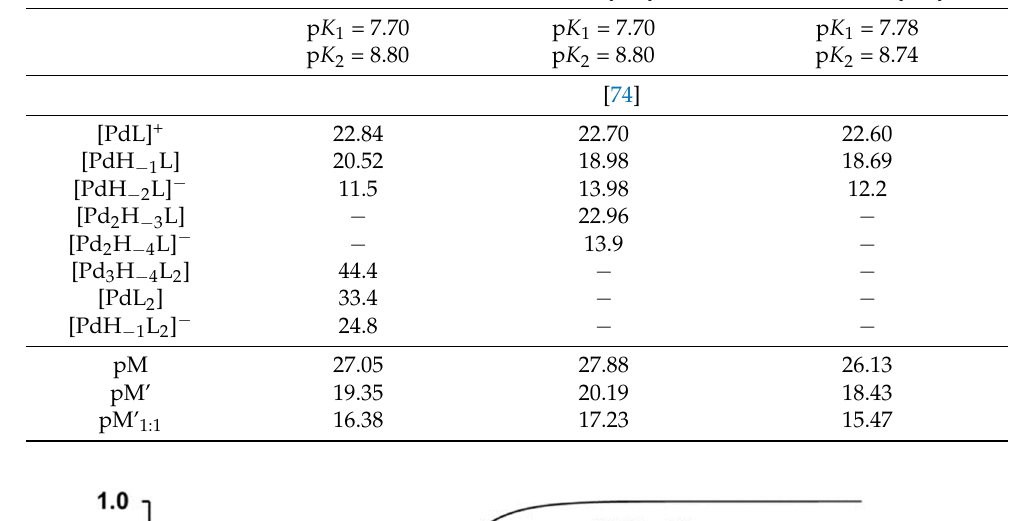
Table 5. Dissociation constants (p K ) of the ligands and overall stability constants (log β ) of their Pd(II) complexes at I tot = 0.20 M (0.10 M KCl + 0.10 M KNO 3 ) and 25.0 ◦ C. H 2 -AlaAlaha +